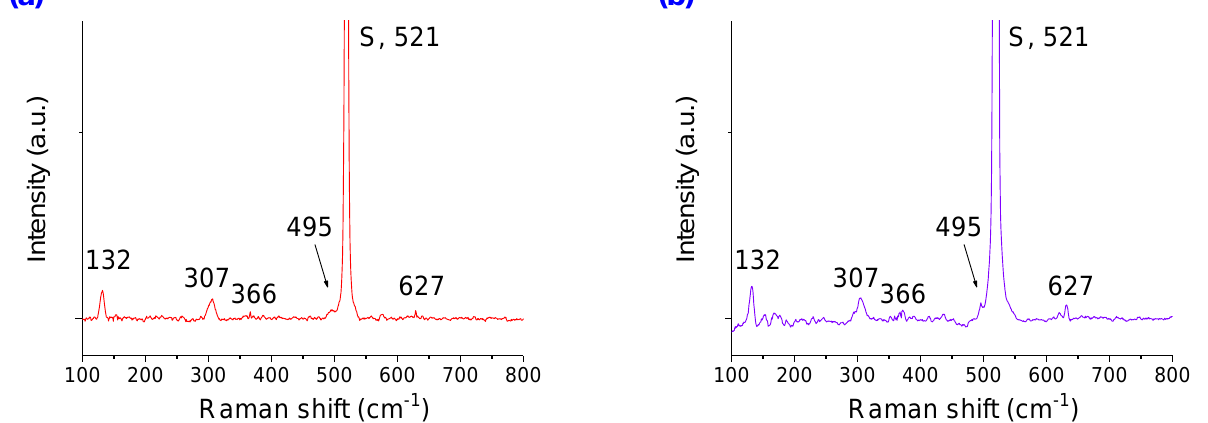
Figure 2. Raman scattering spectra of In 2 O 3 thin film prepared on Si substrate ( a ) before and ( b ) after Pt treatment. The large peak at 521 cm −1 from the Si substrate is labeled as “S”. Pt treatment. The large peak at 521 cm − 1 from the Si substrate is labeled as